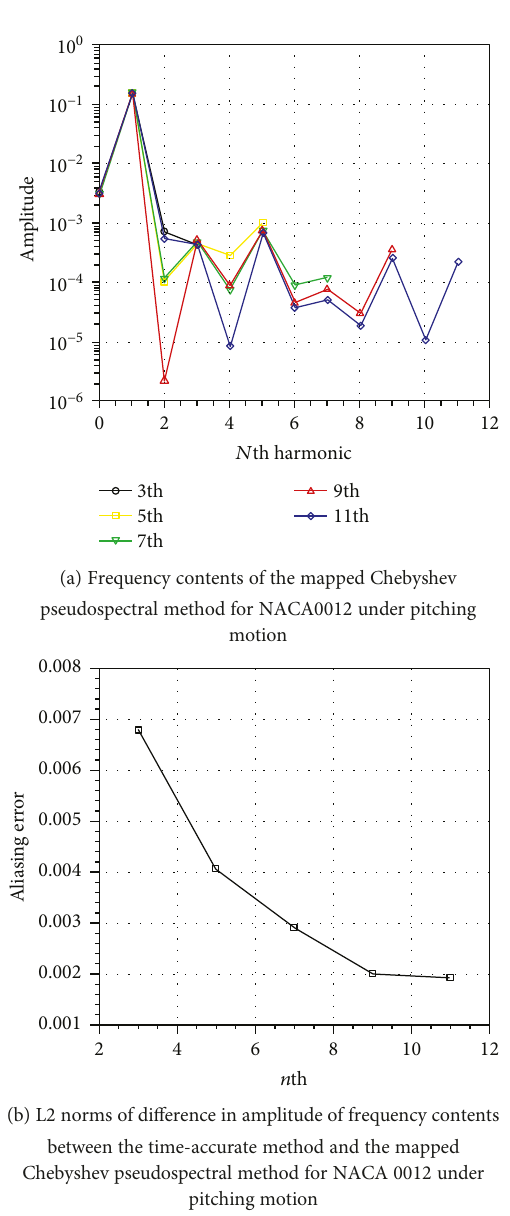
Figure 2: Frequency analysis for the time-accurate method and the time-spectral method results.